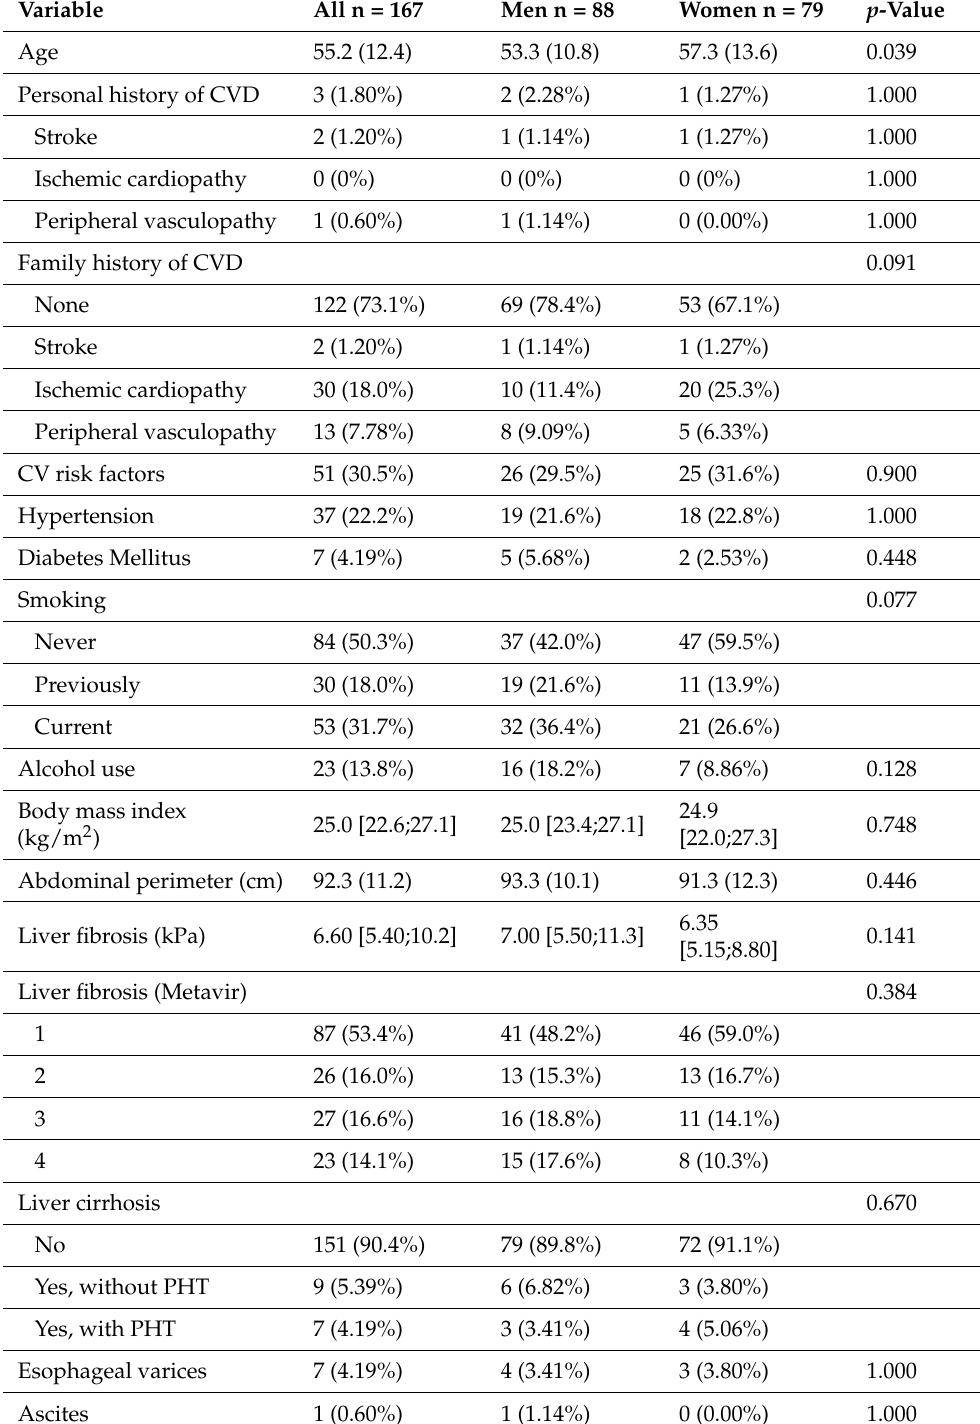
Table 1. Clinical status and patient